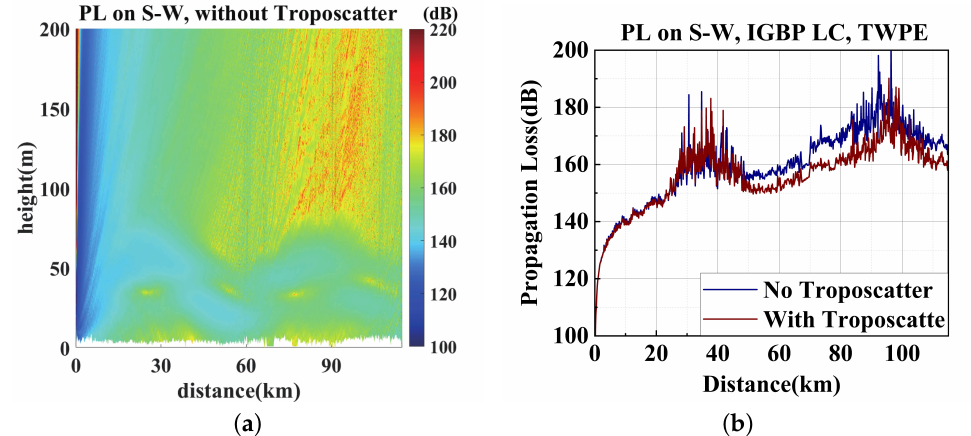
Figure 16. The PL on Shanghai–Wuxi ( a ) in space ( b ) at a height of 60 m. ( a ) PL on Shanghai–Wuxi without the troposcatter. ( b ) PL on S–W at a height of 6 0m with or without the